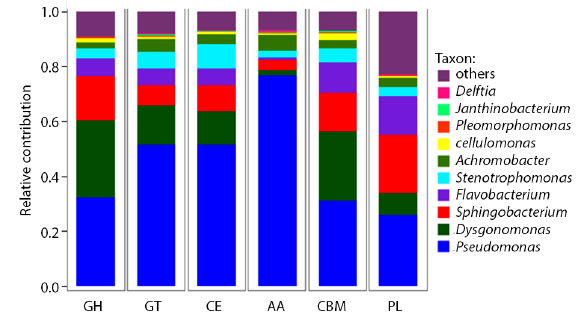
Figure 4. Bar plot of species and functional contribution analysis of GF-20